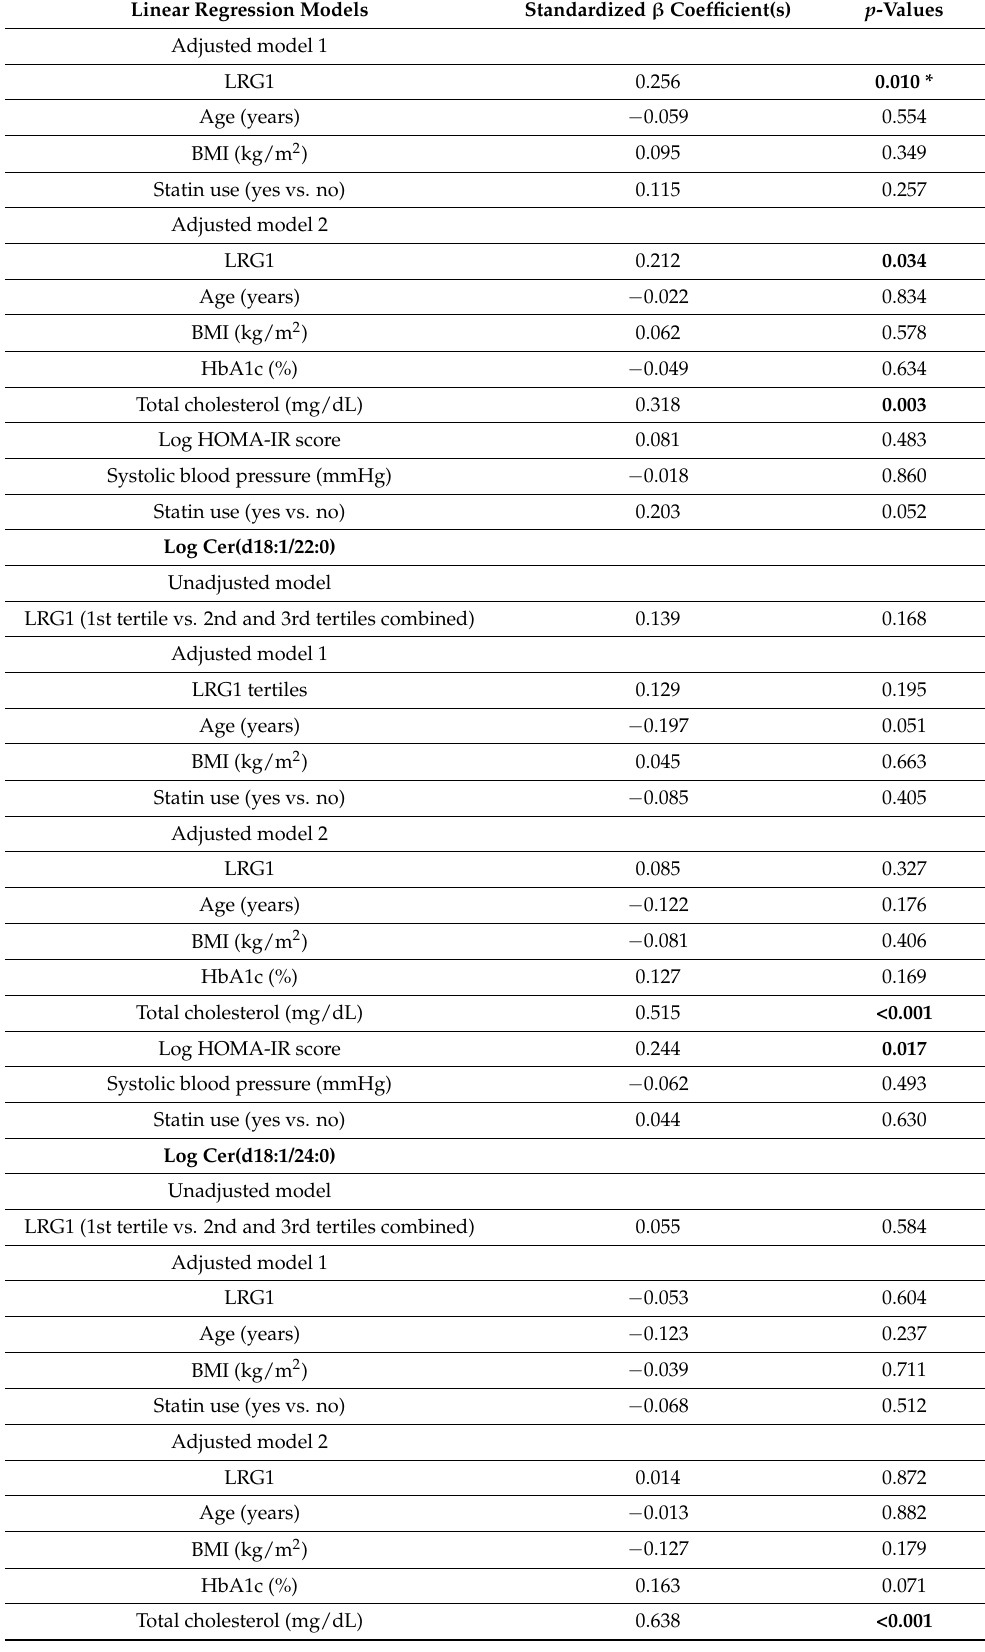
Table 2. Cont. Linear Regression